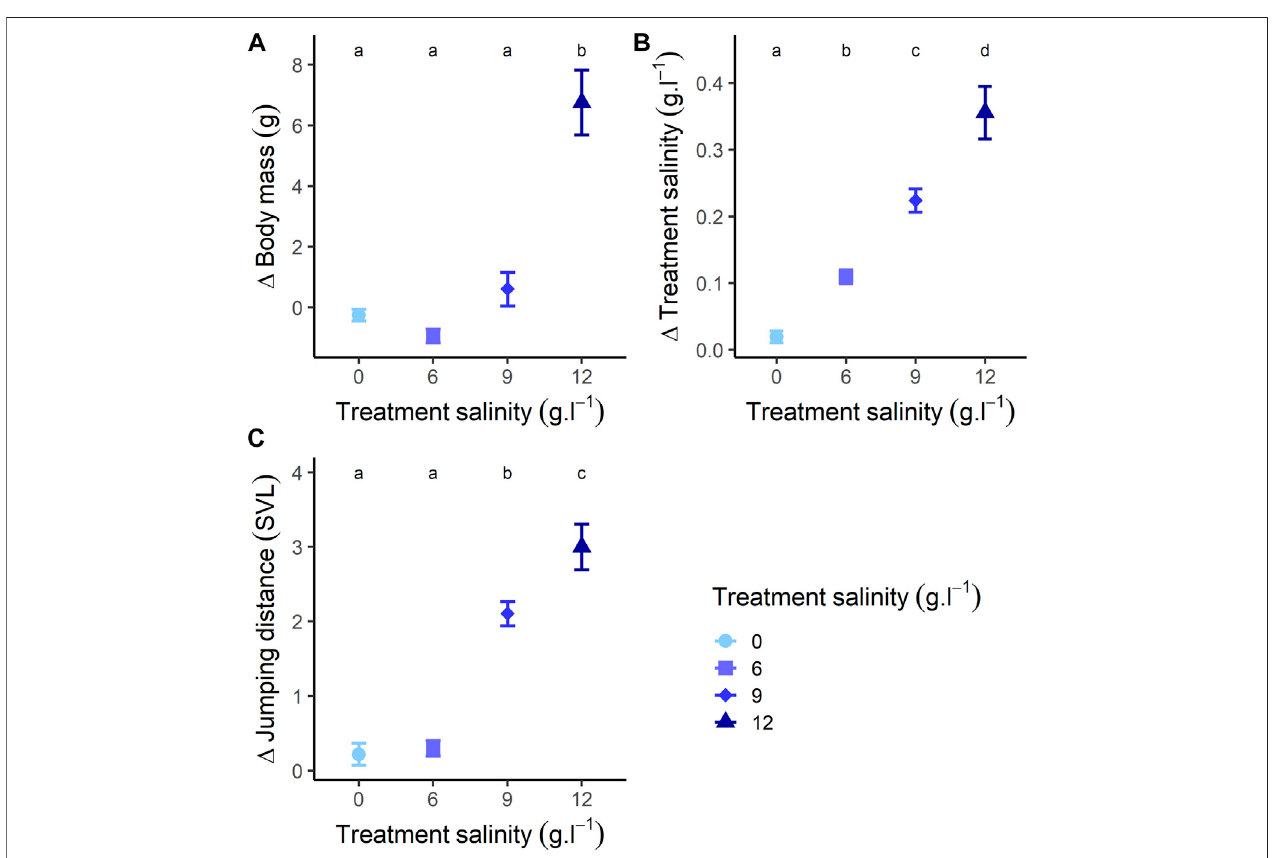
FIGURE 3 | Changes of (A) body mass, (B) salinity (changes in salt concentration during recovery), and (C) jumping performance (relative to individuals body size: mean distance [mm]/individuals body size [mm]), at the end of the recovery (24 h recovery) compared to the beginning of the recovery. Different letters represent a signi fi cative difference at α = 0.05 for variations during